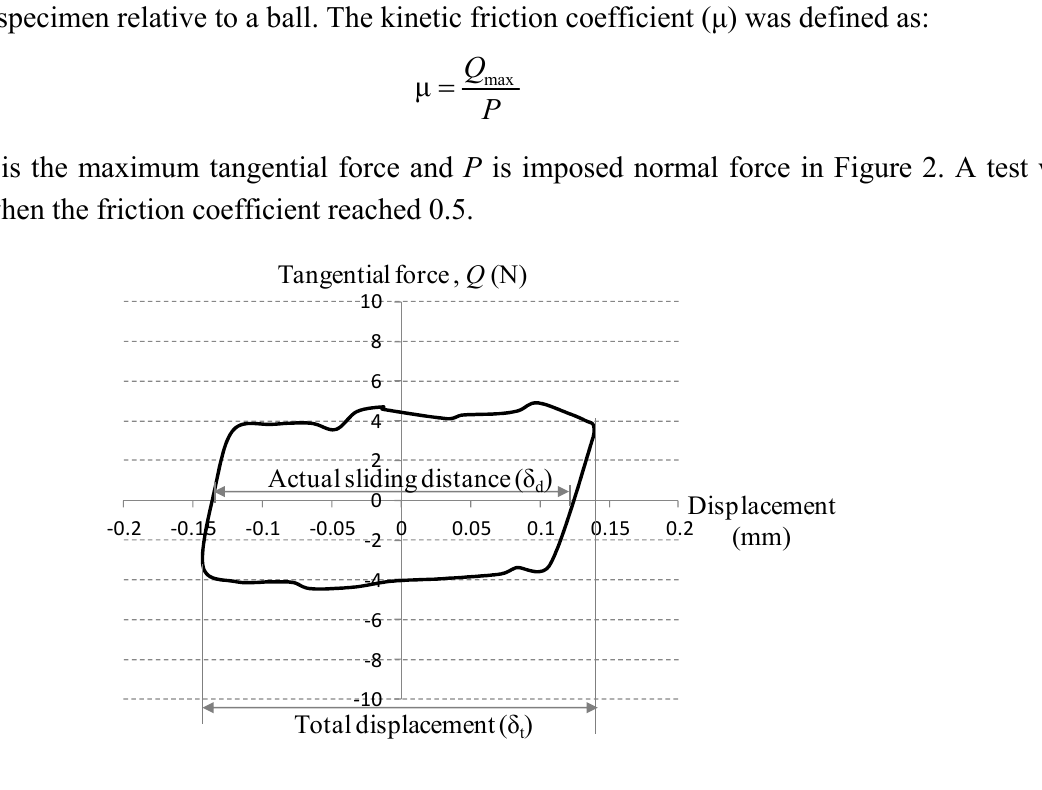
Figure 2. The initial fretting loop for an electro-deposited coating against a conventional